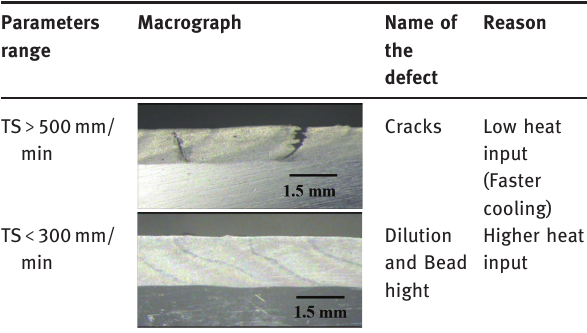
Figure 1: Arrangements of laser